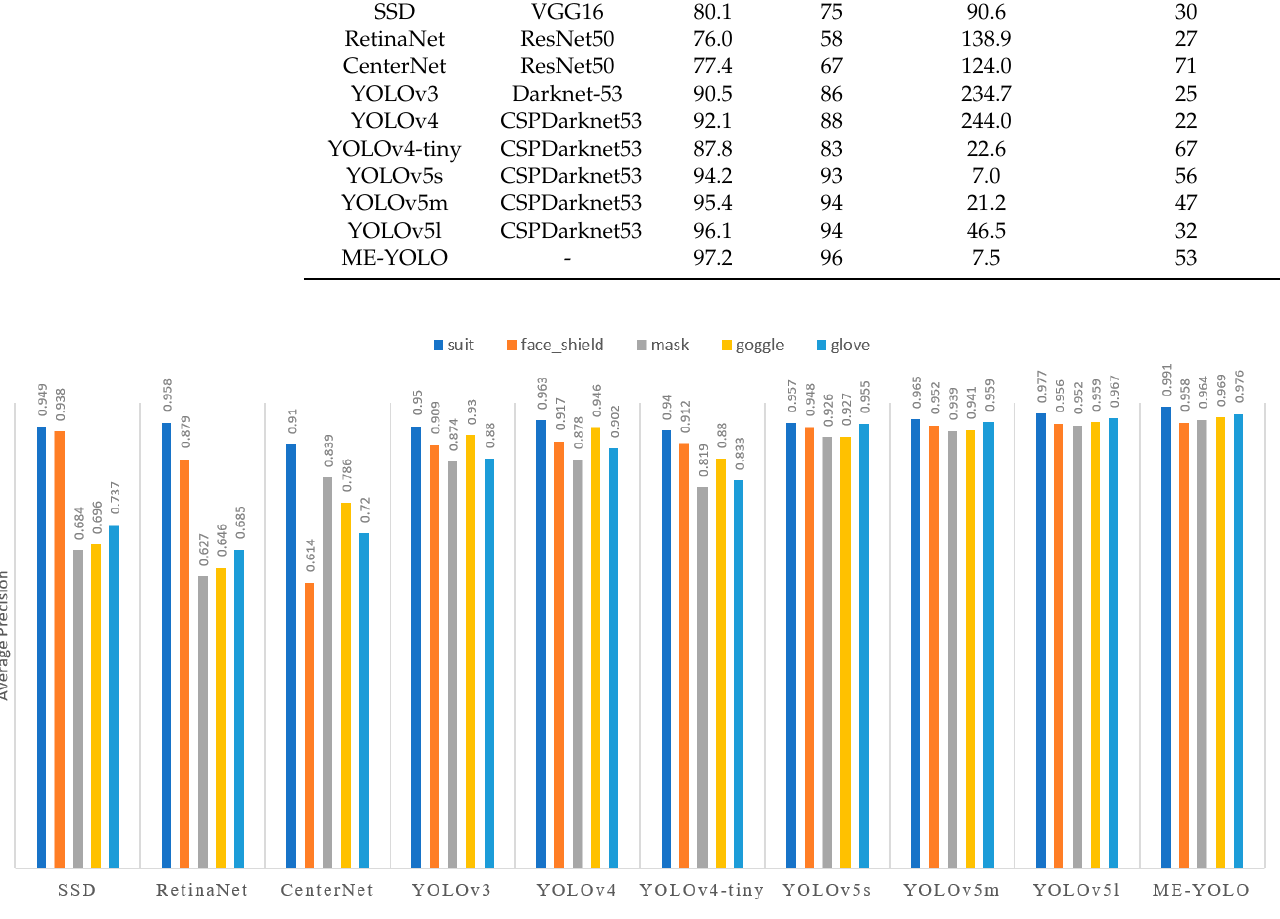
Figure 11. AP for each model.